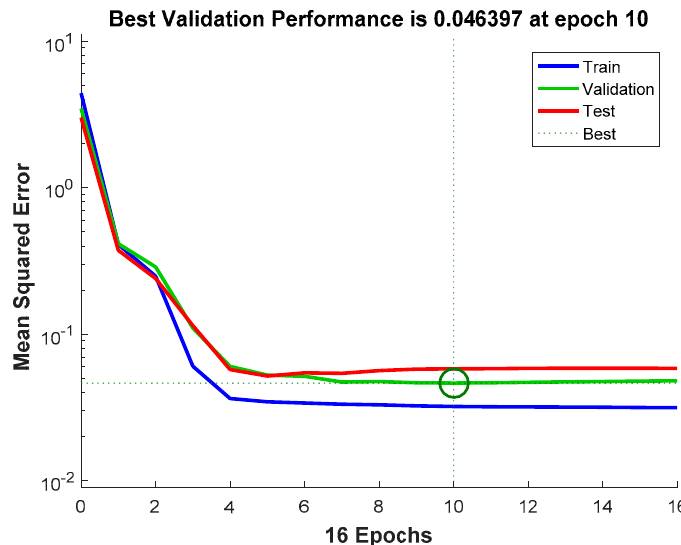
Figure 14. Mean squared error diagram in different epochs of training process for estimating the boiler efficiency.